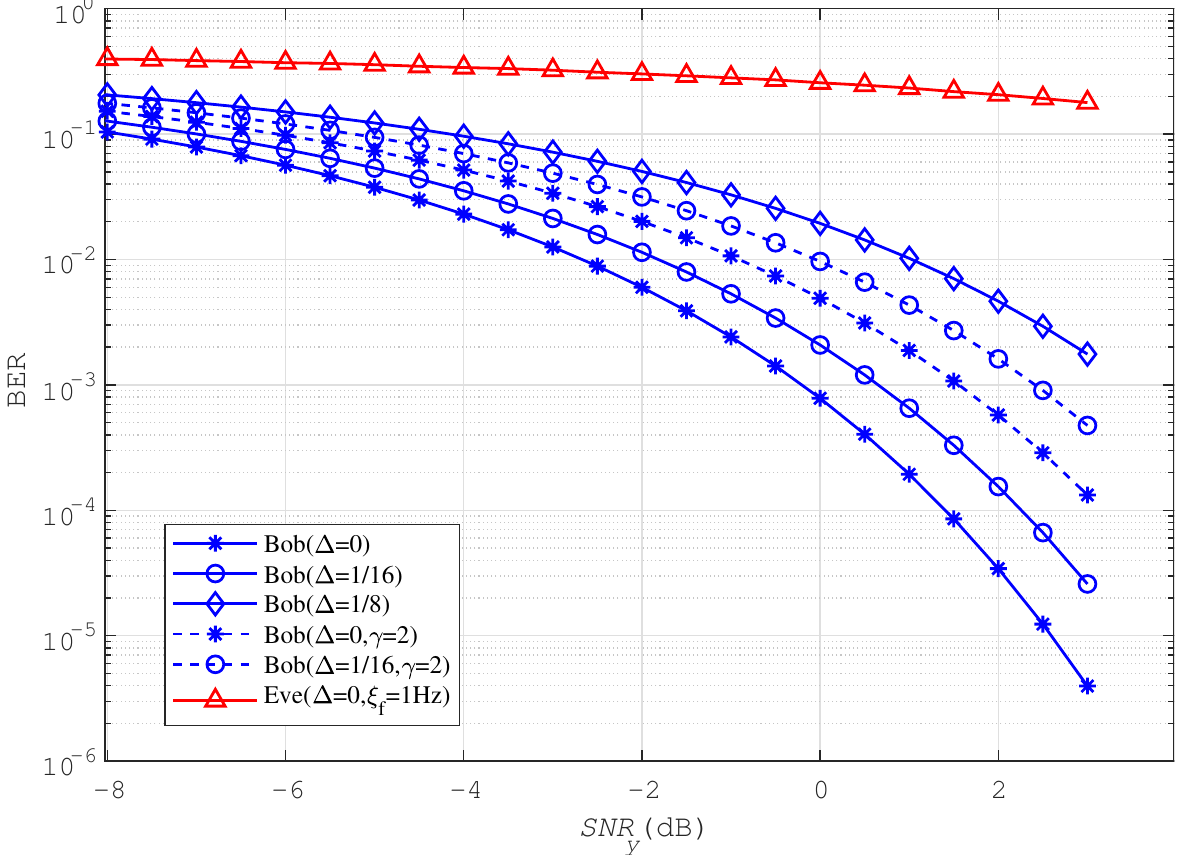
Figure 9. BER performance of Bob and Eve over AWGN channel for D = 5 and N =